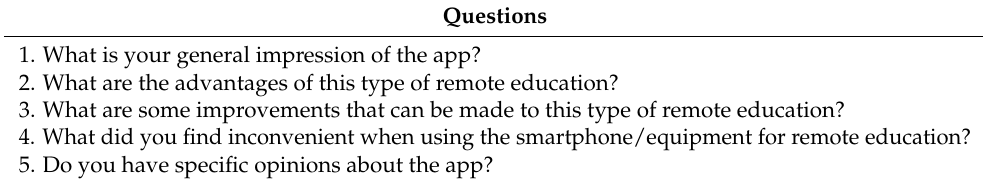
Table 3. Questions for Comment